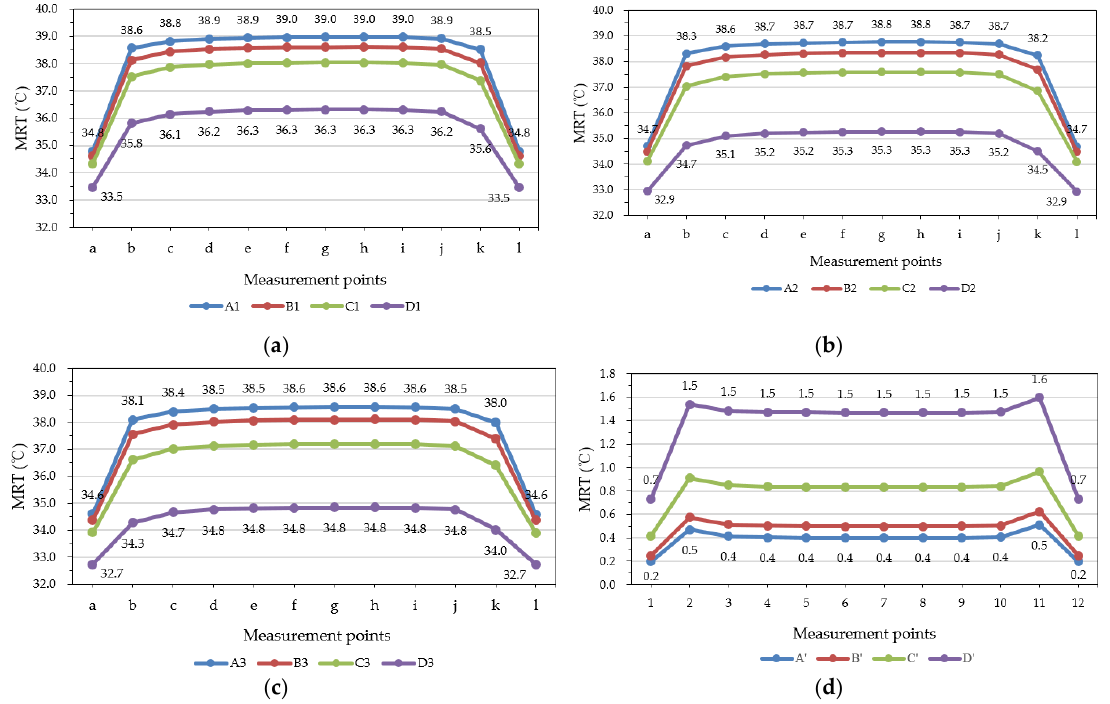
Figure 9. MRT variation in the pedestrian space between the teaching buildings. ( a ) MRT values at a height of 0.5 m; ( b ) MRT values at 1 m; ( c ) MRT values at 1.5 m; ( d ) MRT differences between points at heights of 0.5 and 1.5 m.